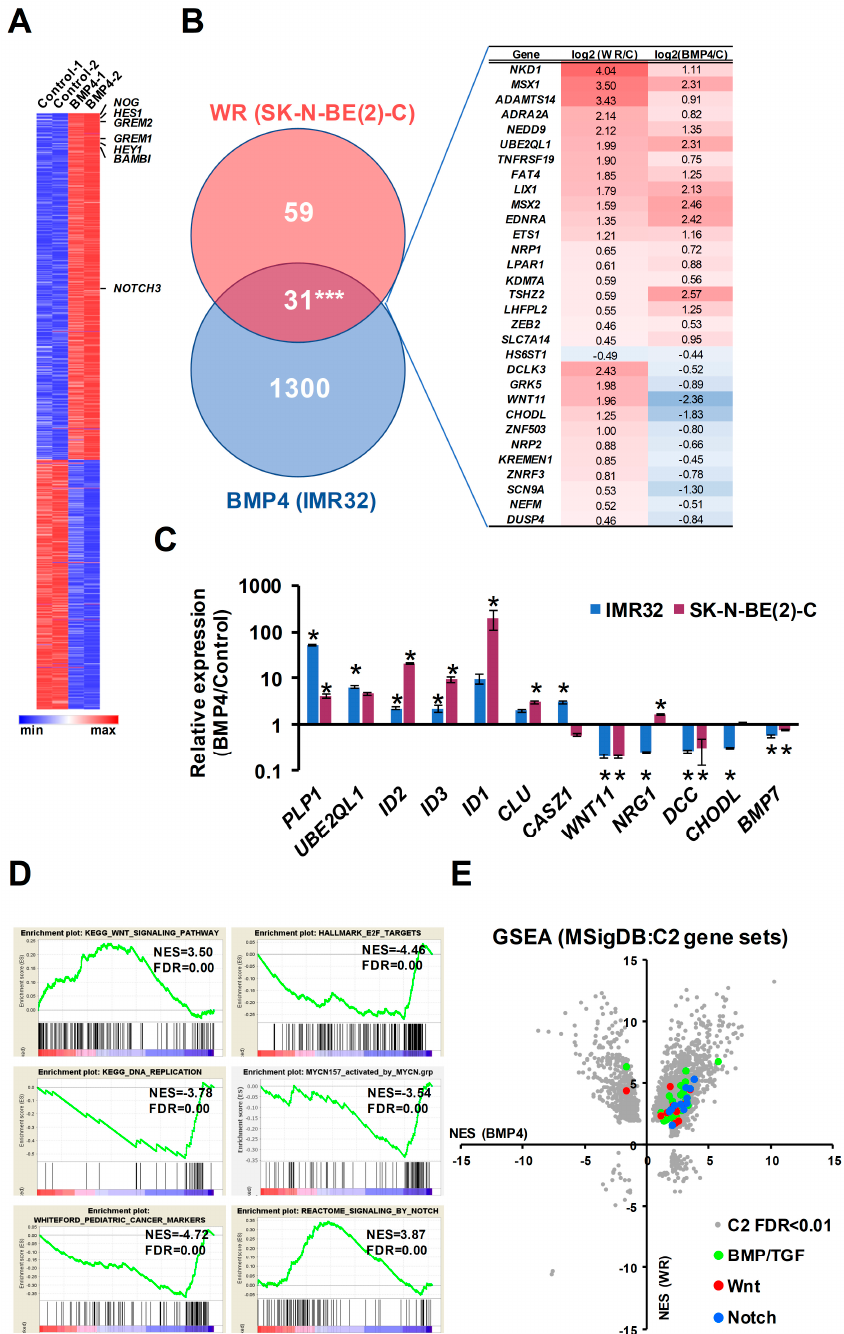
Figure 5. RNA-seq analysis of BMP4-treated IMR32 cells reveals Wnt and BMP4 signaling crosstalk in neuroblastoma cells. ( A ) Heatmap of DEGs in IMR32 after 24H BMP4 treatment (5 ng/mL), p < 0.005 (DESEQ2), minimum fold change 1.3. Canonical BMP4 and Notch target genes are indicated. ( B ) Venn diagram and heatmap of shared target genes of BMP4 and WR datasets in neuroblastoma cells. The number of shared genes is significantly higher than expected by chance (hypergeometric test p = 4.8e − 22). ( C ) Validation of BMP4 target genes in 2 neuroblastoma cell lines; statistically significant di ff erences ( p < 0.05) are indicated by asterisks ( n = 3). ( D ) GSEA highlighting significant regulation of functional gene sets. ( E ) Comparative GSEA analysis of C2 gene sets (Molecular Signatures Database, Broad Institute) in BMP4-treated IMR32 and WR-treated SK-N-BE(2)-C cells reveals upregulation of BMP / TGF ( n = 29), Wnt ( n = 12) and NOTCH ( n = 11) gene sets by both